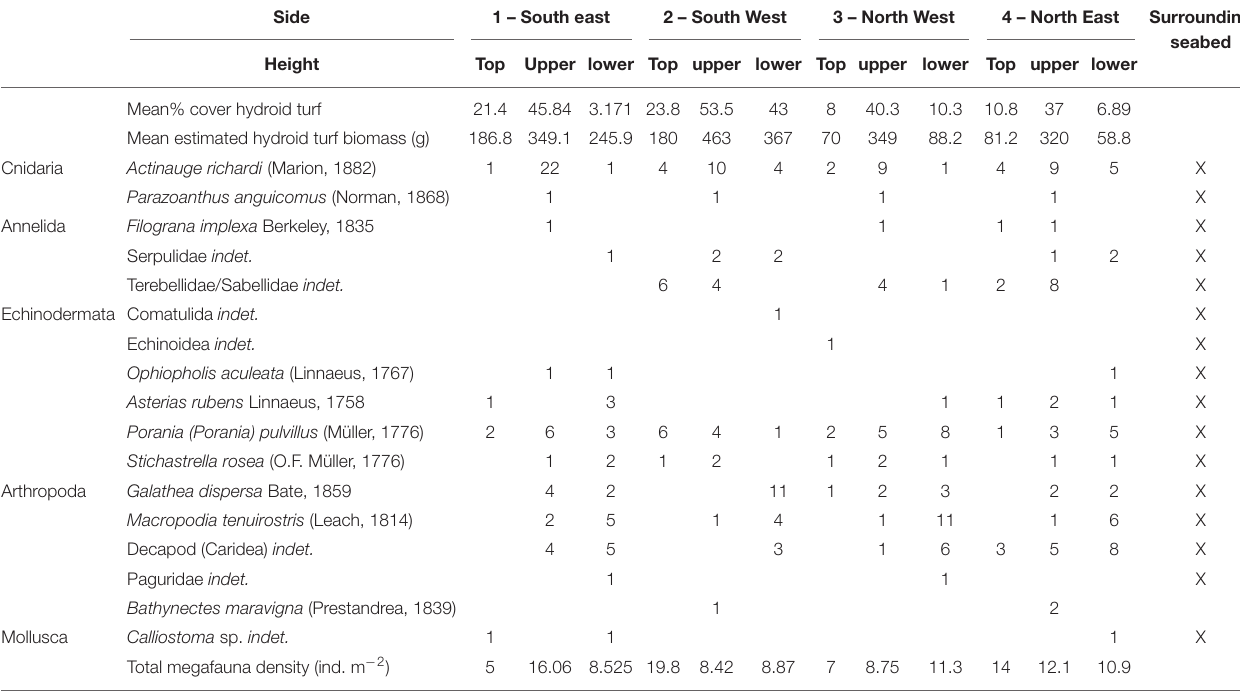
TABLE 5 | Hydroid turf percentage cover and epibenthic megafaunal abundance on the visually surveyed sample panels of the protective